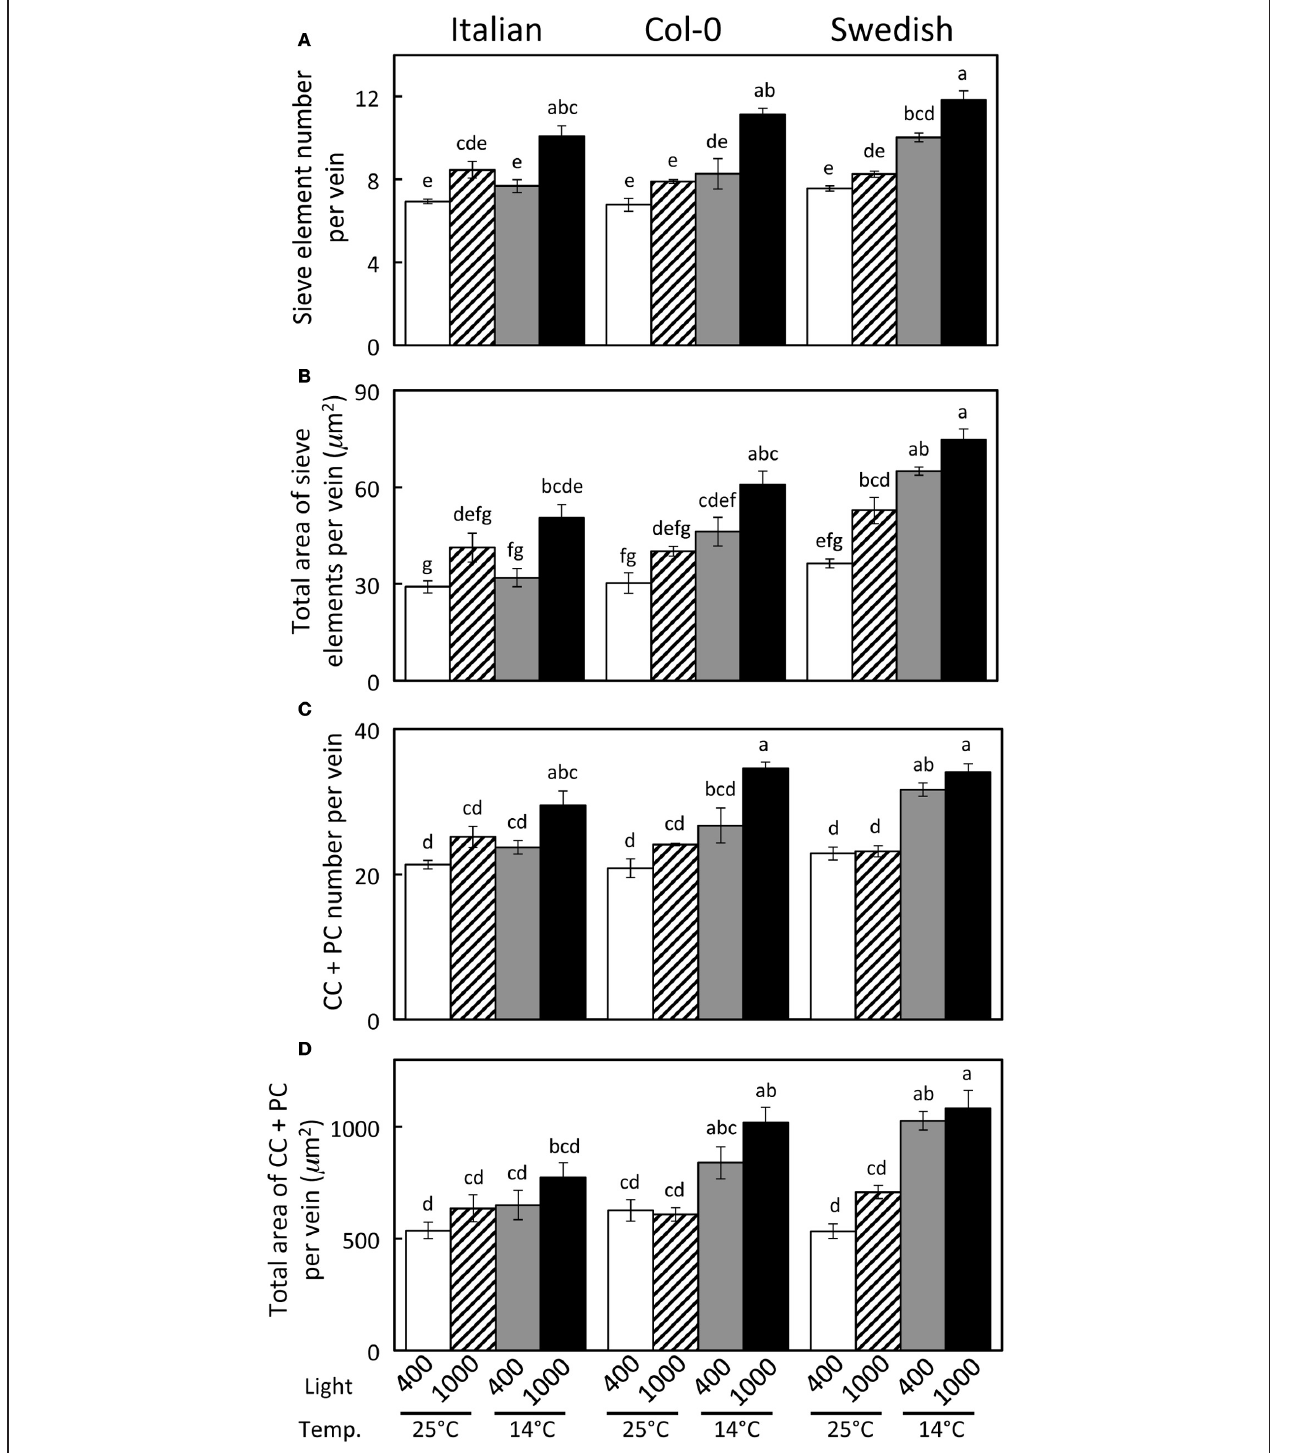
FIGURE 3 | Characterization of fourth- and third-order veins (veins containing ≤ 14 sieve elements and phloem area/vein area ≥ 0.5) from leaves of Italian, Col-0, and Swedish ecotypes of A. thaliana grown under different controlled temperature ( ◦ C daytime leaf temperature) and light ( µ mol photons m − 2 s − 1 ) conditions. ( A ) Sieve element number per minor loading vein. ( B ) Cross-sectional area of sieve elements per minor